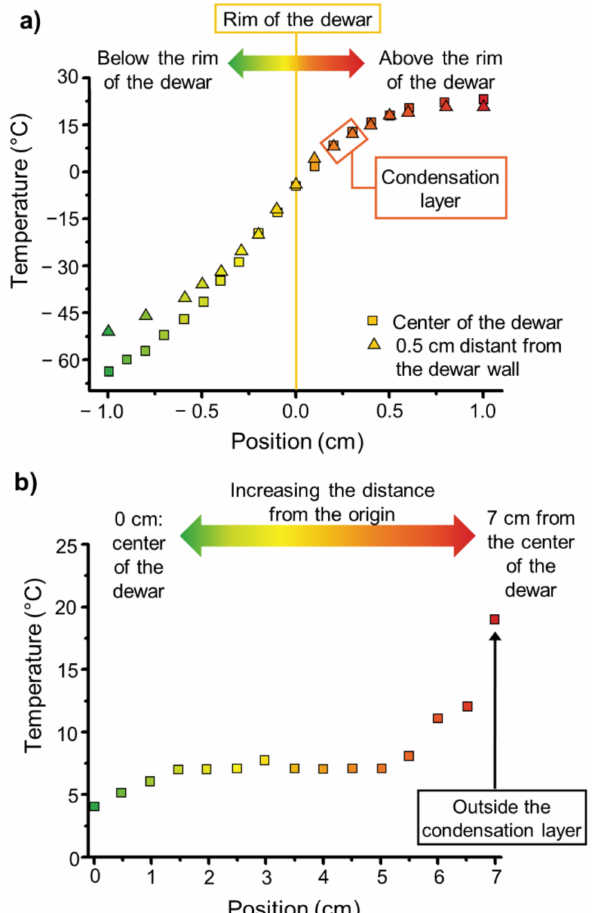
Figure 3. ( a ) Temperature variation along the vertical, measured with a thermocouple in the Dewar center and at 0.5 cm from its wall. The zero is at the rim height. ( b ) Radial temperature change in the condensation layer. The origin is the Dewar center.